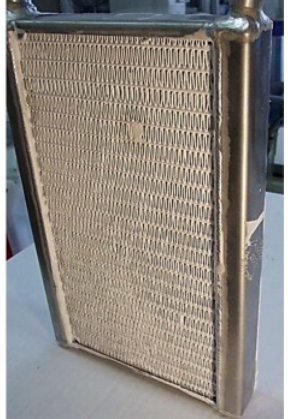
Figure 4. Flat tube–fin coated adsorber [28].